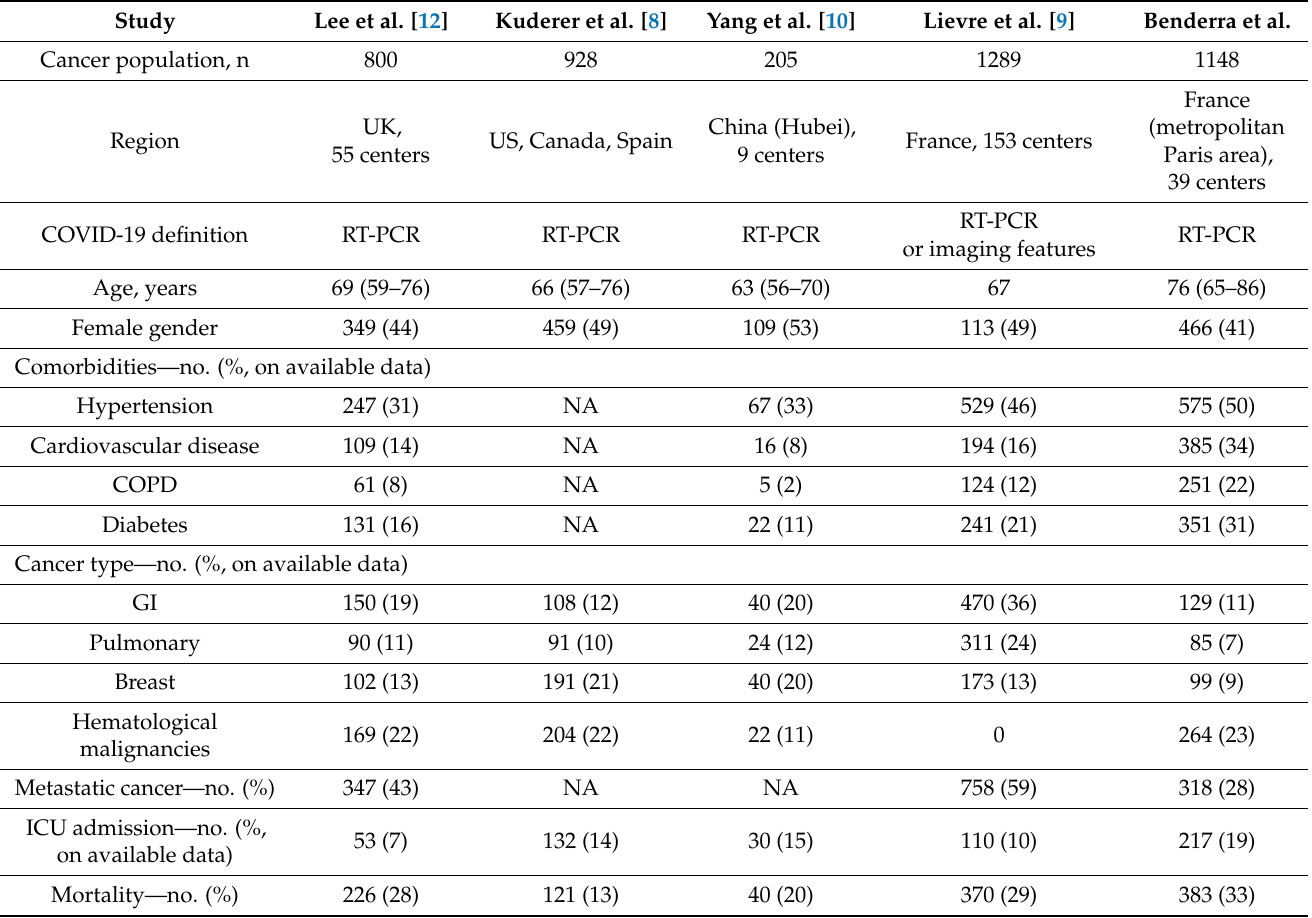
Table 3. Main Cohort studies with COVID-19 cancer patients. Abbreviations: NA, Not Available; COPD, chronic obstructive pulmonary disease; ICU, Intensive Care